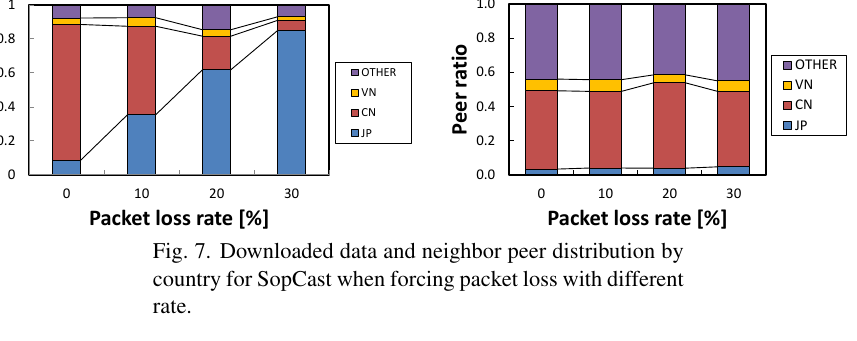
Fig. 7. Downloaded data and neighbor peer distribution by country for SopCast when forcing packet loss with different rate.